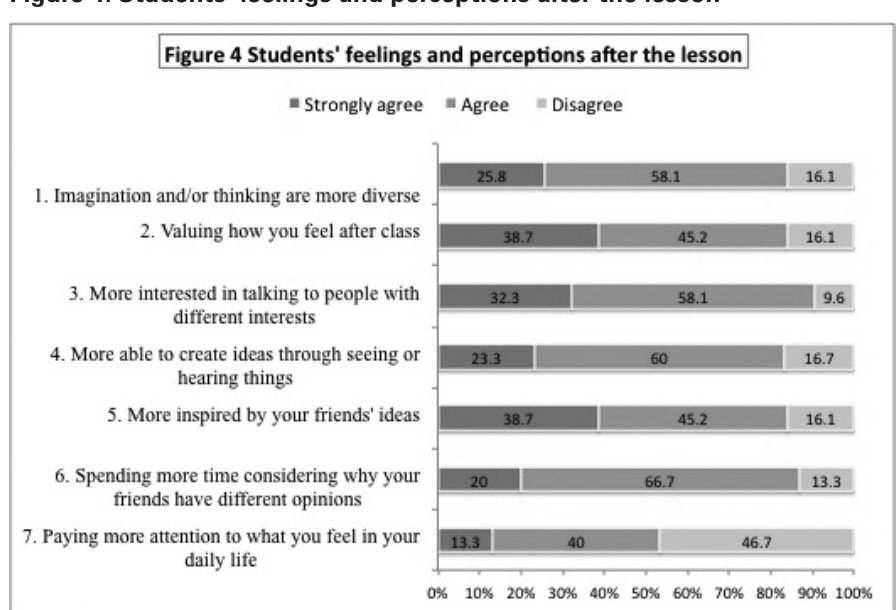
Figure 4: Students’ feelings and perceptions after the